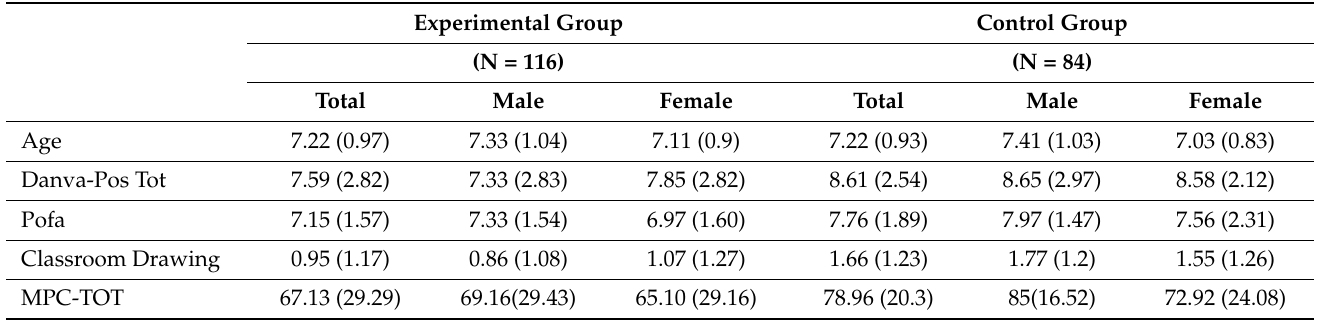
Table 1. Mean (SD) of total scale, by age and group.